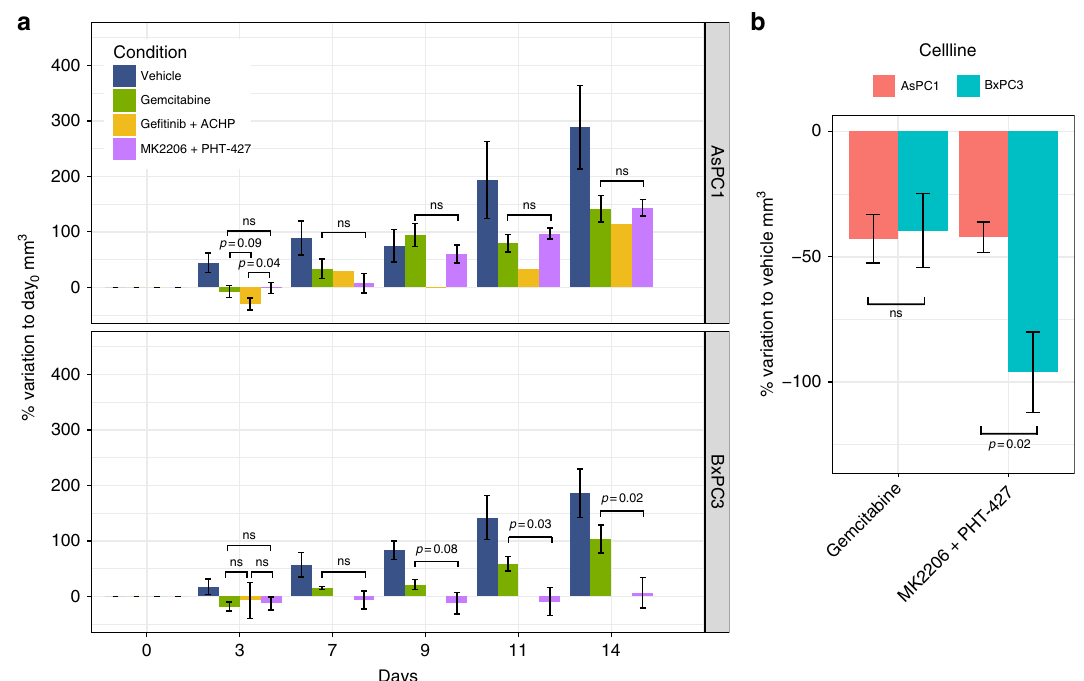
Fig. 5 In vivo validation of drug combinations in mouse xenograft models. a Percentage increase of tumour size (mm 3 ) with respect to the fi rst day of treatment (day 0) for AsPC1 and BxPC3, respectively. Statistical comparisons are reported with the corresponding p -value (if <0.1) or as ‘ ns ’ (not signi fi cant) when p -value >0.1. b Percentage variation with respect to the vehicle is shown to directly compare the two cell lines when treated with Gemcitabine or combination of MK2206 and PHT-427. For both panels, p -values are computed using one-tailed t -test and error bars represent the standard error of the mean. The experiment started with 5 mice per each group, error bars are not reported for the condition Ge fi tinib + ACHP after the third day, where only one mouse